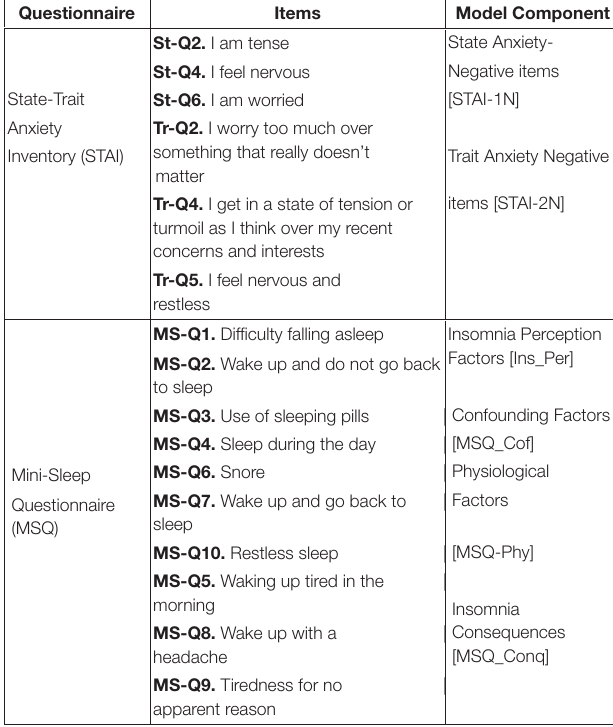
TABLE 1 | List of selected questions from state-trait anxiety inventory (Gorenstein and Andrade, 1996) and mini-sleep questionnaire (Falavigna et al., 2011) for each model’s